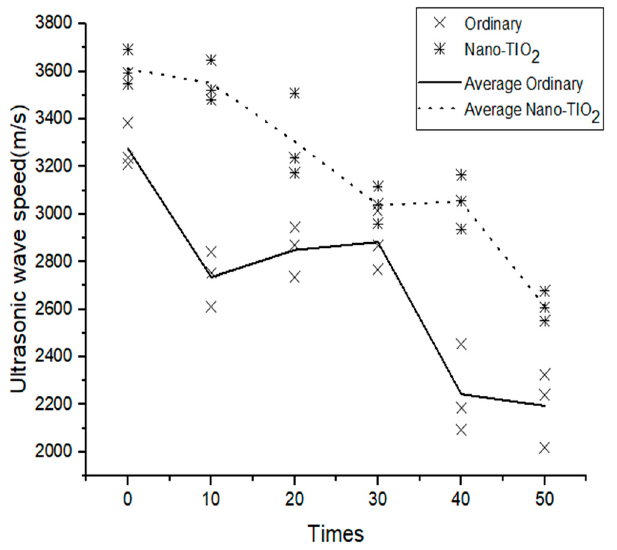
Figure 3. The influence of dry–wet cycles on the concrete ultrasonic wave velocity.